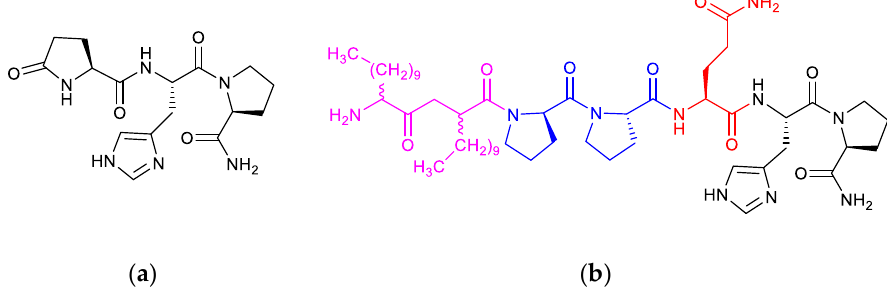
Figure 1. Chemical structure of ( a ) Thyrotropin-releasing hormone (TRH) and ( b ) its C12-C12-Pro-Pro-Gln-His-Pro-NH 2 prodrug ( 1 ) extended from the N-terminus of Gln-His-Pro-NH 2 ( 2 ) with a pair of 2-aminododecanoyl (C12) residues as lipoamino acids (LAAs) (magenta) and a dipeptidyl (Pro-Pro) prolyl oligopeptidase (POP)-sensitive linker (blue).